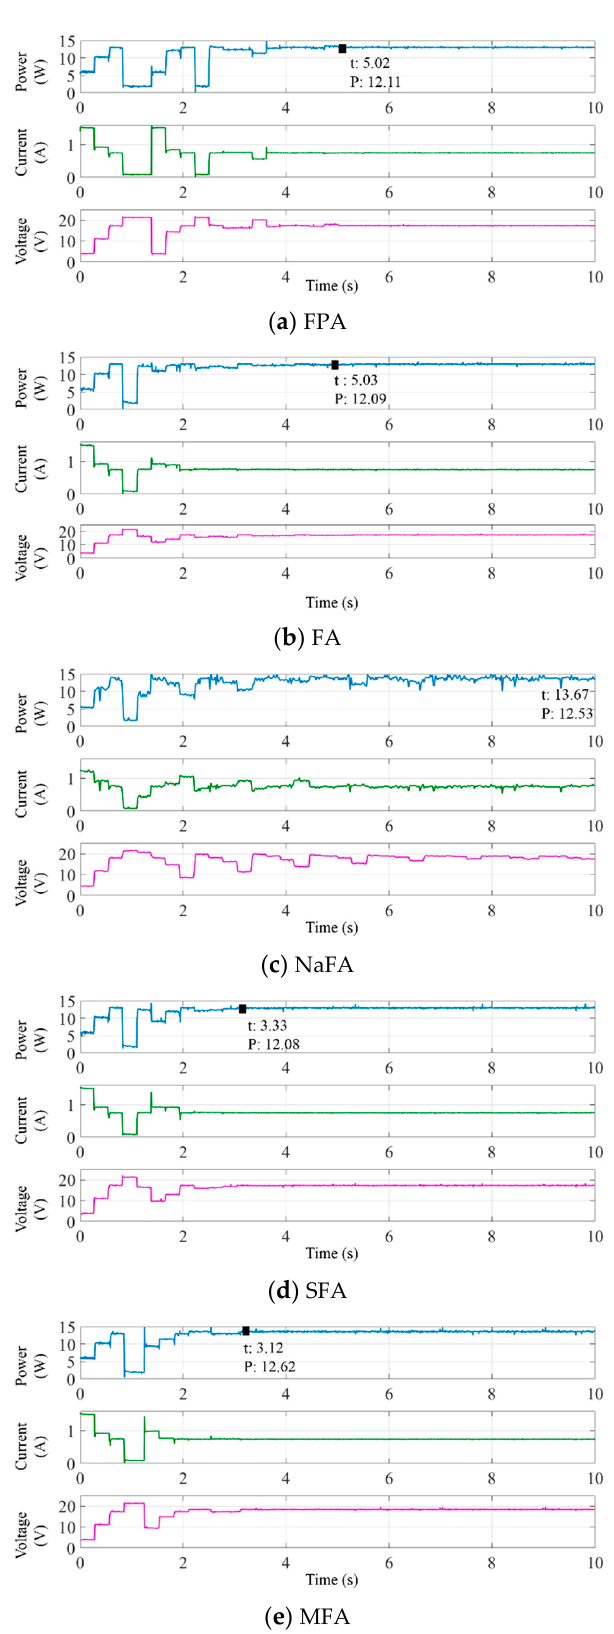
Figure 20. Power, current and voltage variations during one evaluation tracking process of the five algorithms under Pattern #10.